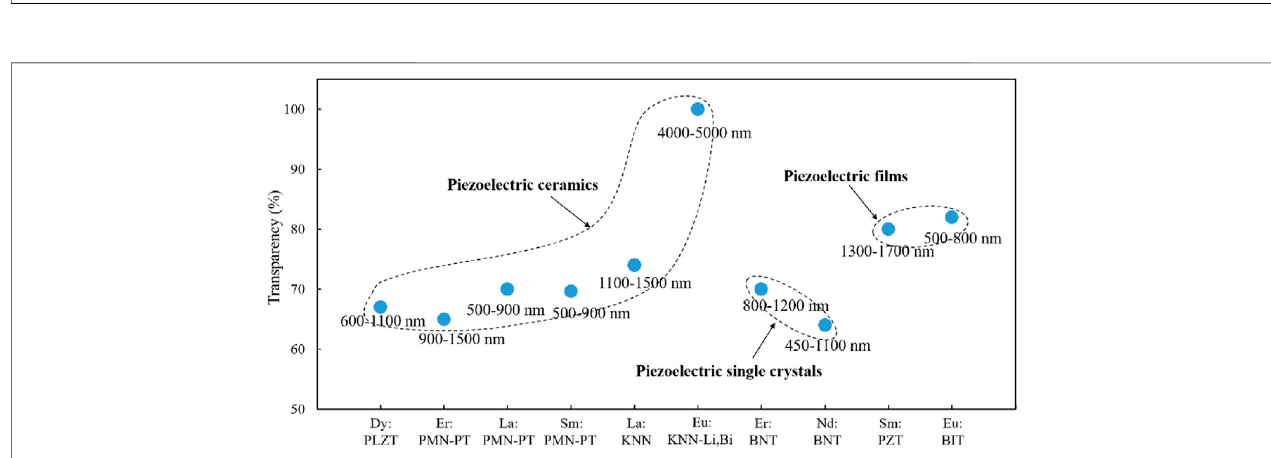
FIGURE3| Thepropertiesofsomepiezoelectricceramicswithrare-earthdoping(Pandeyetal.,2009;Pengetal.,2010a;Yaoetal.,2010;Wangetal.,2012;Hao et al., 2015; Peng et al., 2016; Guo et al., 2019a; Guo et al., 2019b).